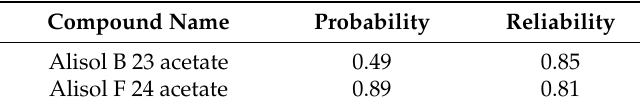
Table 1. The P-gp inhibitor probability and reliability.